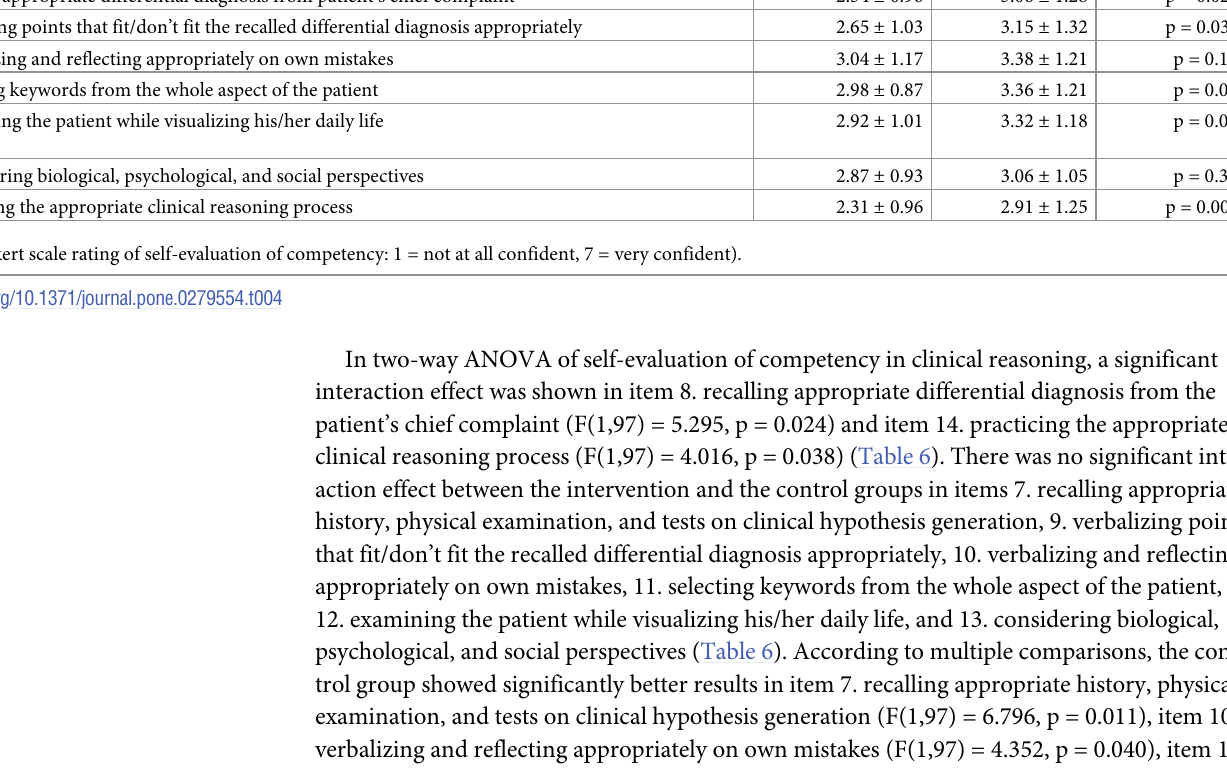
Table 5. ANCOVA in fifth-year medical students’ self-evaluation of competency in clinical reasoning after the educational intervention based on the 7-point Likert scale about hybrid- and pure-PBL, Chiba University Hospital (N = 99). Questionnaire (7-point Likert